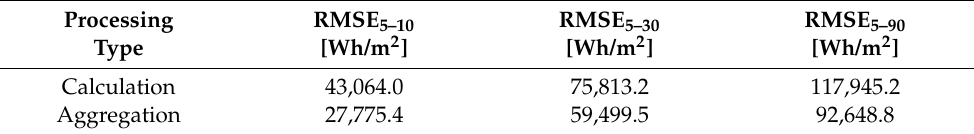
Table 6. Comparison of the differences in potential solar radiation calculated and aggregated at a spatial resolution of 10 m, 30 m, and 90 m. The model with which these models are compared is calculated with a resolution of 5